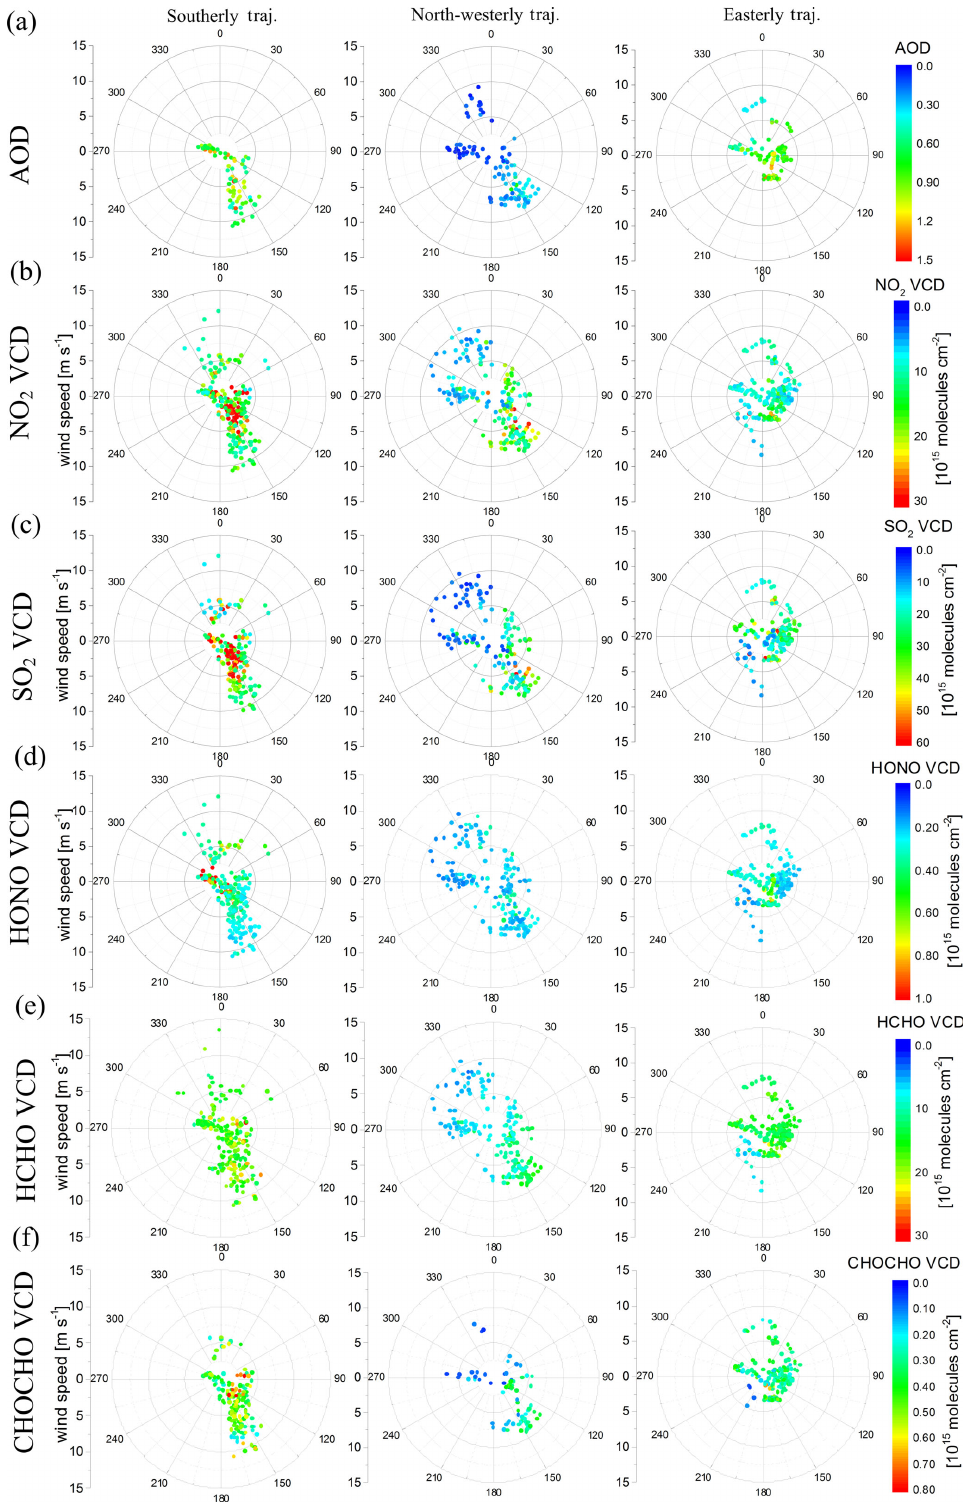
Figure 13. Bivariate figures of AOD (a) and VCD of NO 2 (b) , SO 2 (c) , HONO (d) , HCHO (e) and CHOCHO (f) as function of wind speed and direction for the three groups of days with the different dominant directions of night-time trajectories. The colours show values of AOD and